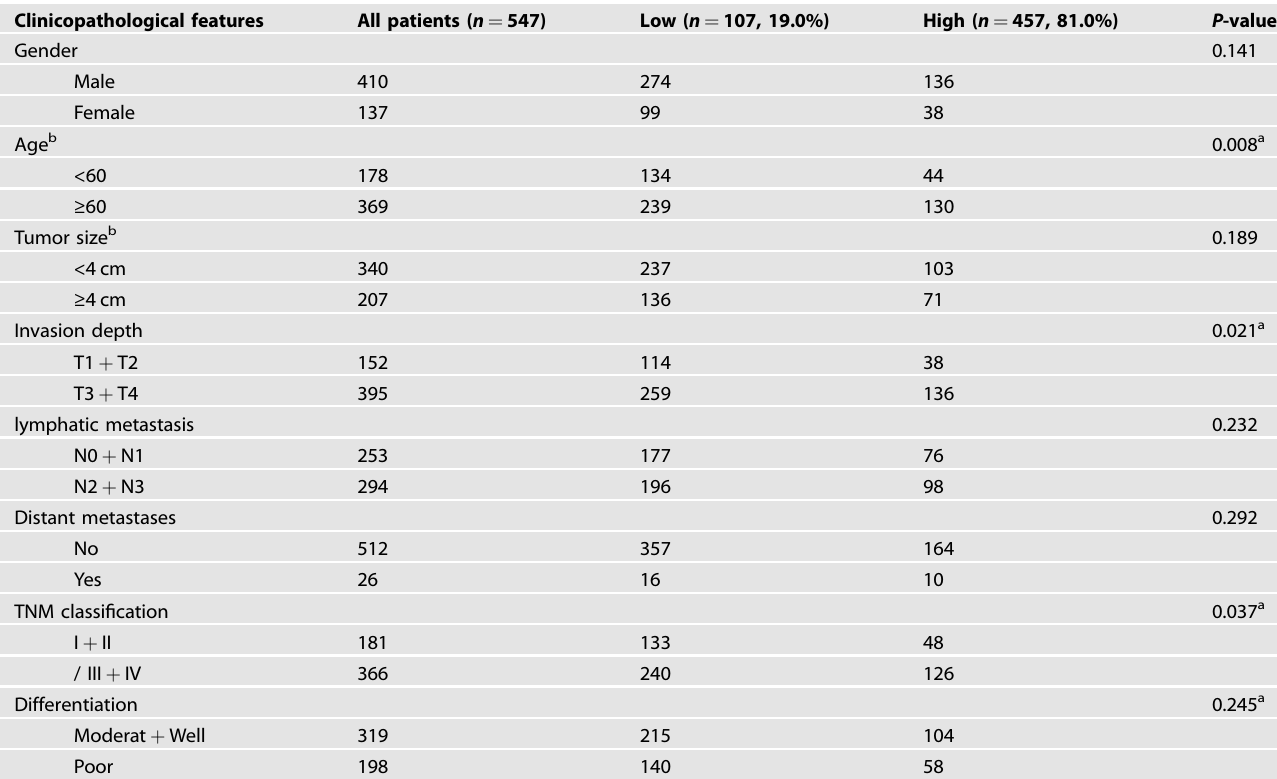
Table 1. Clinicopathological features and ASAP1 in GC. Clinicopathological